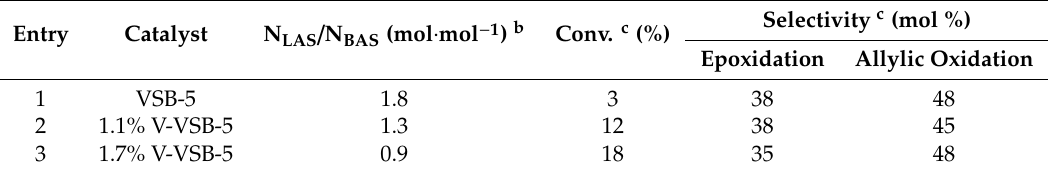
Table 24. Oxidation of α -pinene over V-VSB-5 catalysts. Influence of the Brönsted and Lewis sites a (adapted from reference [82]).